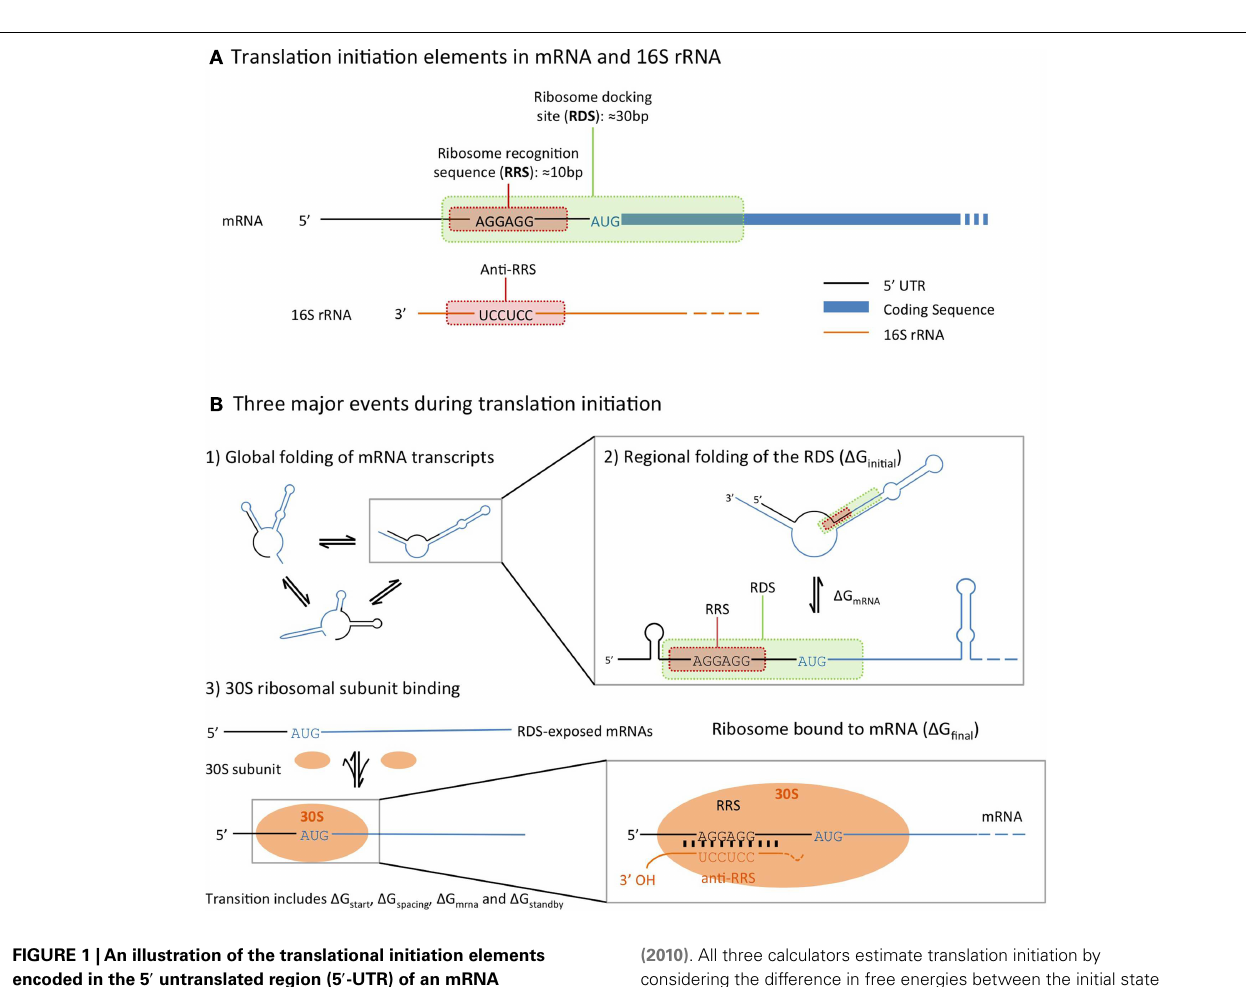
FIGURE 1 |An illustration of the translational initiation elements encoded in the 5 (cid:48) untranslated region (5 (cid:48) -UTR) of an mRNA (A), and the three major events that affect prokaryotic translation initiation (B), following the model described by Na and Lee